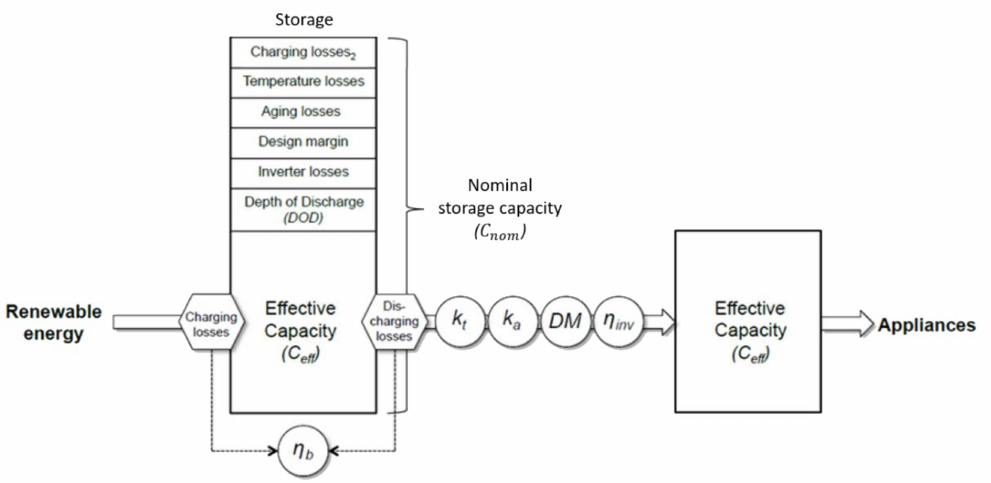
Figure 4. Electricity flow through a storage system and associated parameters (authors’ own).